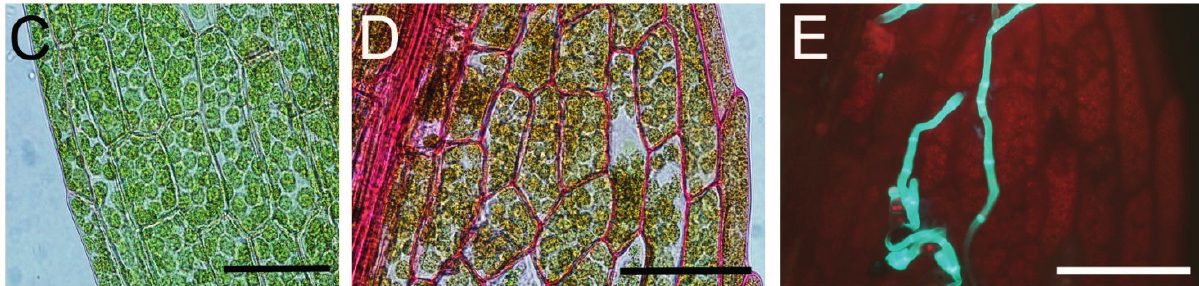
Figure 3. Cell wall-associated defenses in C. gloeosporioides -infected tissues. ( A ) C. gloeosporioides -infected cells showing brown cell walls at 2 DAI; ( B ) Same leaf as A stained with solophenyl, hyphae inside the cells are indicated with a white arrow; ( C ) Control leaf; ( D ) C. gloeosporioides -infected leaf stained with safranine-O at 2 DAI; ( E ) Same leaf as D stained with solophenyl. Scale bars represent 50 μ